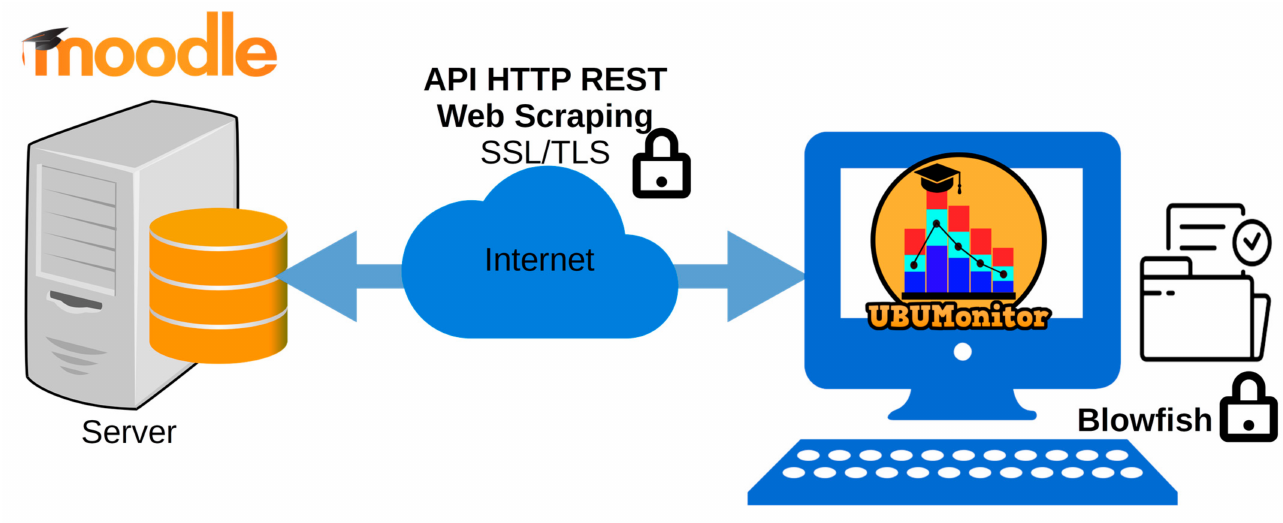
Figure 2. Diagram of the operation of the UBUMonitor